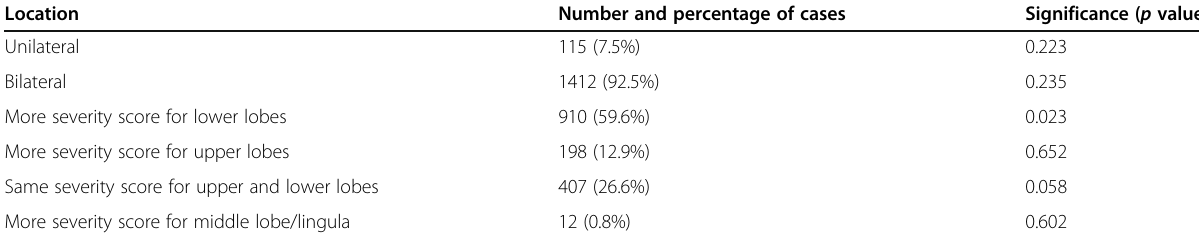
Table 2 Correlation between CT-SS value and the common CT chest findings in patients with COVID-19 pneumonia